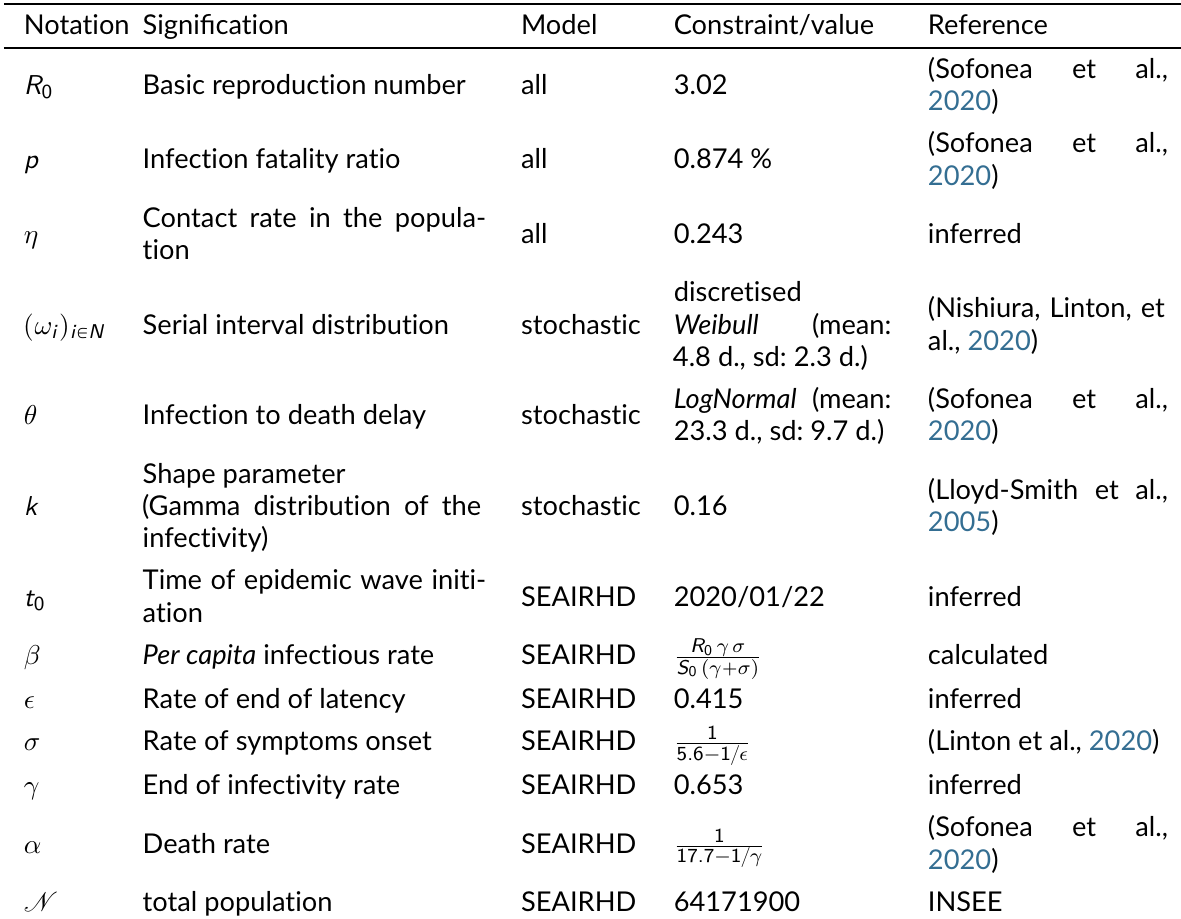
Table S1 – Models parameters and